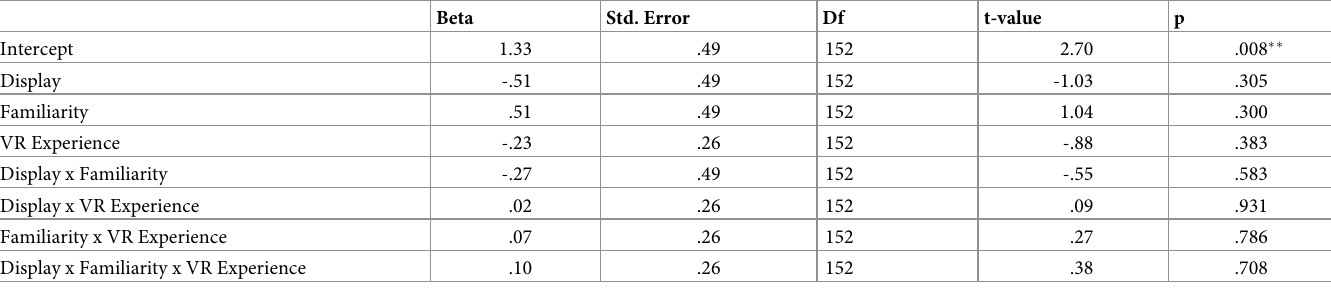
Table 1. Full model results for type 1